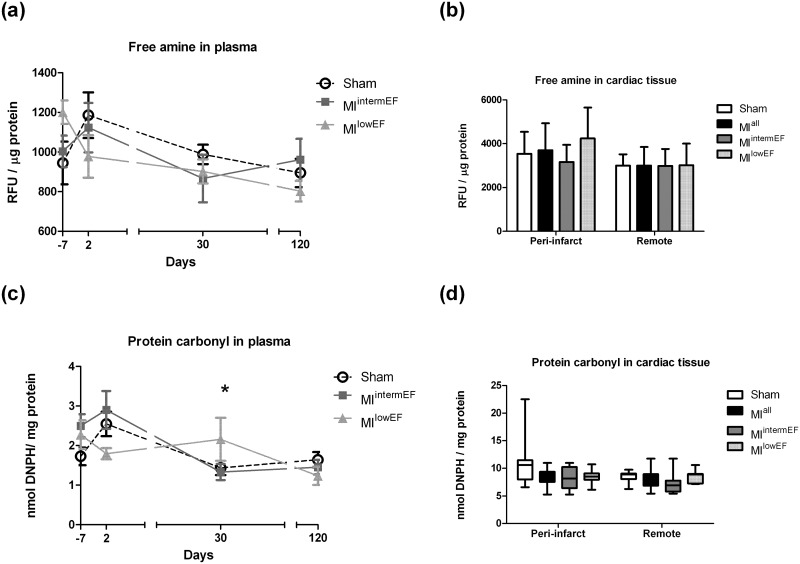
Reactive free amine and protein carbonyl levels.Reactive free amine levels in plasma (a) and in cardiac tissue (b). Protein carbonyl in plasma (c) and in cardiac tissue (d). Statistical analysis: GEE (a and c), data expressed as mean ± SE; ANOVA with Tukey’s test (b), data expressed as mean ± standard deviation (SD); Kruskal-Wallis with Dunn test (d), data expressed as median ± SE. * Difference vs. MIintermEF (p < 0.05; sham group, n = 15; MI group, n = 7 per group). RFU: relative fluorescence units; DNPH: 2,4-dinitrophenylhydrazine. MIintermEF: EF > 53.7% and < 66.5%; MIlowEF: EF < 53.7.